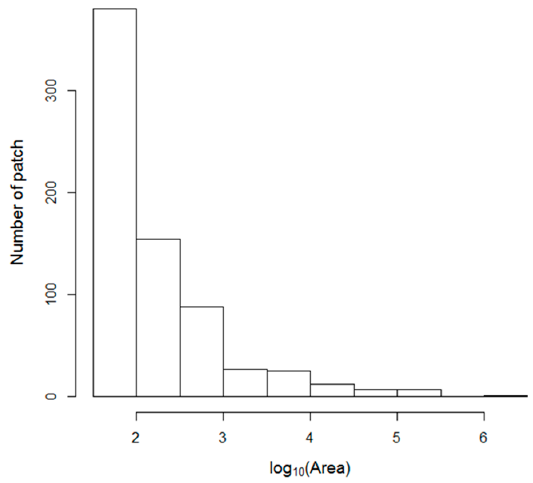
Figure 11. Histogram of the vegetation patch area (m 2 ).